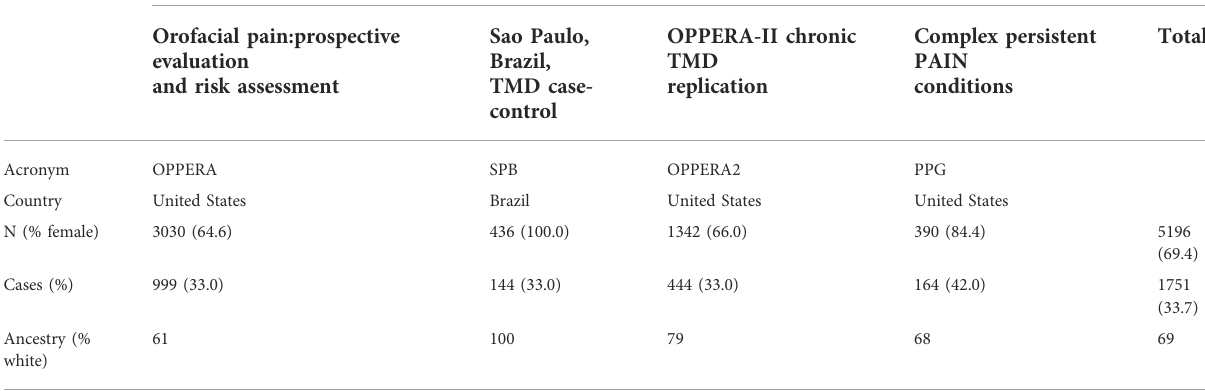
TABLE 1 Demographic data for the four cohorts on Temporomandibular